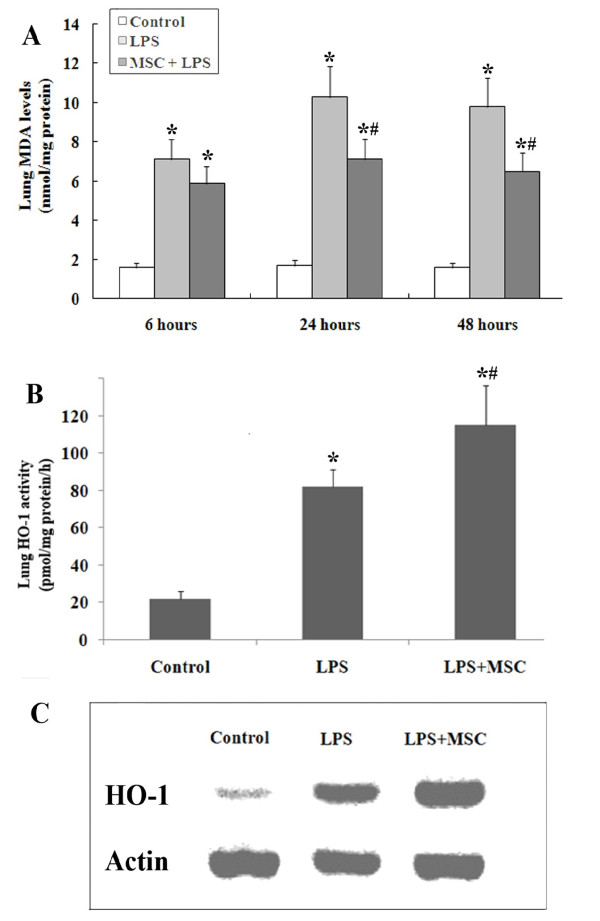
(A) MDA levels were significantly increased in LPS-treated rats compared to the control group. This increase was significantly reduced at 24 and 48 hours by treatment with UC-MSCs. (B) Activity of HO-1 in the lungs of LPS-treated rats at 24 hours. (C) Expression of HO-1 as measured by Western blotting analysis at 24 hours. LPS induced HO-1 protein expression and stimulated HO-1 activity in the lung tissues. Treatment with UC-MSCs further increased the expression and activity of HO-1 (*, p < 0.05 compared with healthy controls; #, p < 0.05 comparing LPS plus UC-MSCs with LPS alone).